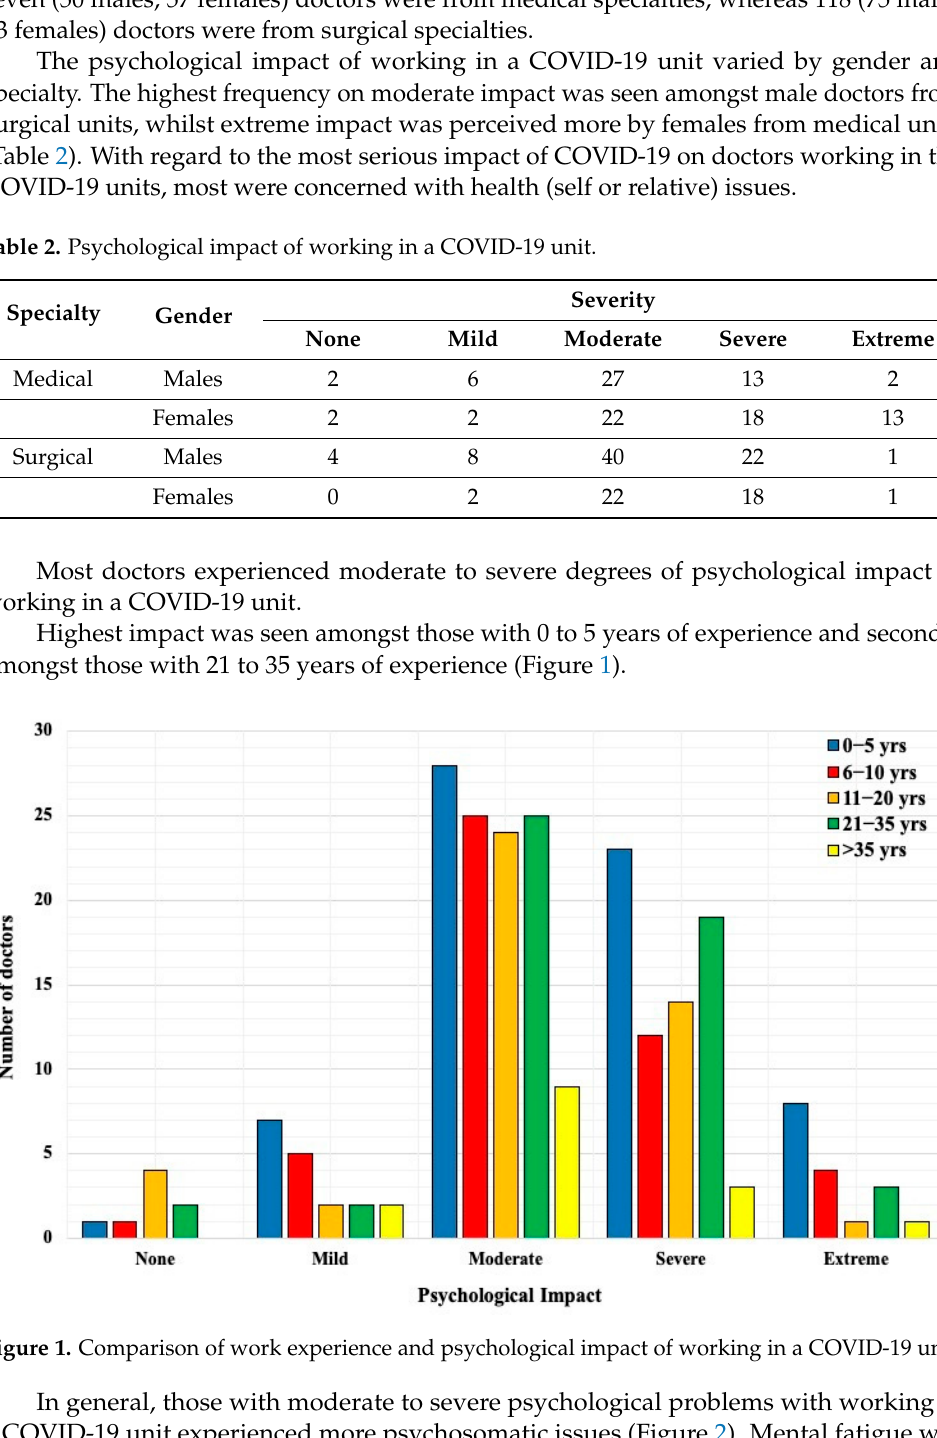
Figure 2. Comparison of psychological impact of working in a COVID-19 unit with increasing work experience and psy- chosomatic effect. A total of 89 doctors tested positive for the SARS-CoV-2 antigen test, amongst these 17 were asymptomatic and quarantined, 51 doctors suffered mild symptoms, 21 had mod-